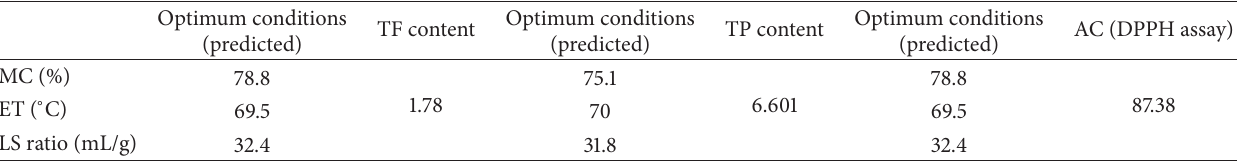
Figure 4: Predicted value of TF, TP, and DPPH activity of Pandan leaf from optimized extraction condition using RSM ((a) optimized condition for TF and DPPH activity; (b) optimized condition for TP). Table 4: Optimum conditions and experimental value of responses at the optimum conditions.